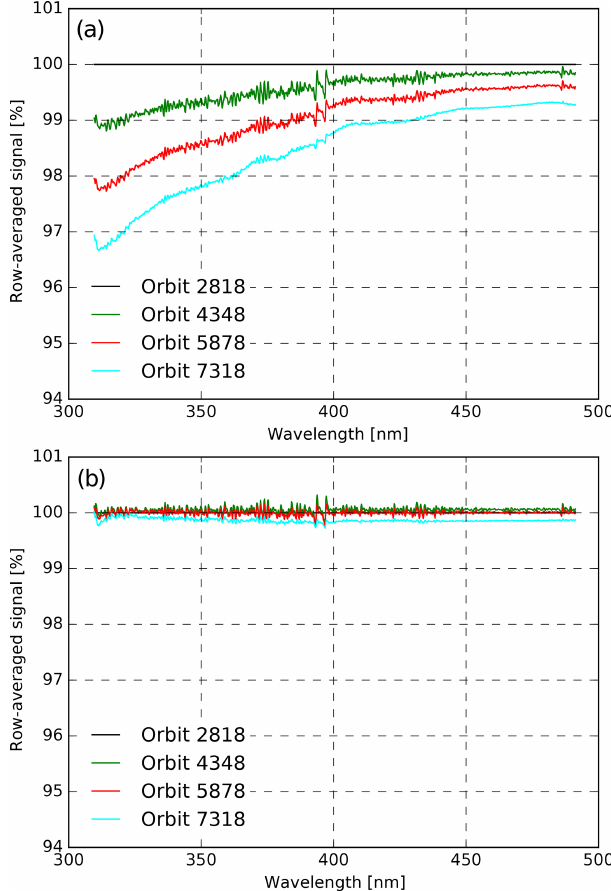
Figure 13. Row-averaged irradiance signal of the UV detector via QVD1 for orbits 2818 (flat black line), 4348 (green), 5878 (red) and 7318 (cyan). The plot (a) is without degradation correction and clearly shows the spectral dependence of the degradation and the increase in signal for some spectral ranges. The plot (b) shows the corrected signal where the degradation CKD used only the mea- surements up to and including orbit 5878. The latest orbit in the plot (cyan) is corrected using extrapolation in the L1b processor.